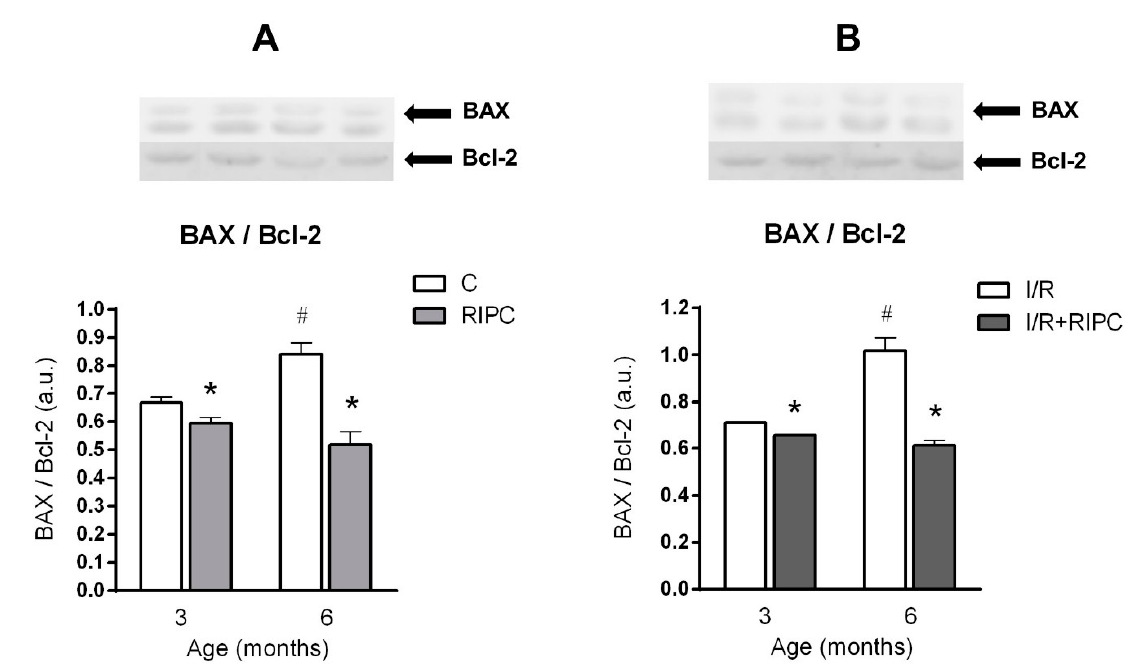
Figure 5. The effect of age and remote ischemic preconditioning on the expression of proteins involved in pro and anti- apoptotic cascades in rat myocardium at the baseline (pre-ischemic) conditions ( A ) and after ischemia/reperfusion ( B ). Samples were taken prior to ischemia (20 min stabilization perfusion) and at 40 min of post-ischemic reperfusion. BAX— pro-apoptotic protein from Bcl-2 protein family (B-cell lymphoma 2), Bcl-2—anti-apoptotic protein from Bcl-2 protein family. ( A , B )—BAX/Bcl-2 (ratio of BAX and Bcl-2 proteins), C—baseline samples, I/R—post-IR samples, RIPC—samples with prior remote ischemic preconditioning. Data are presented as means ± S.E.M of 4–5 hearts per group, normalized to the levels of GAPDH. * p < 0.05 RIPC vs. C; # p < 0.05 vs. 3 months.